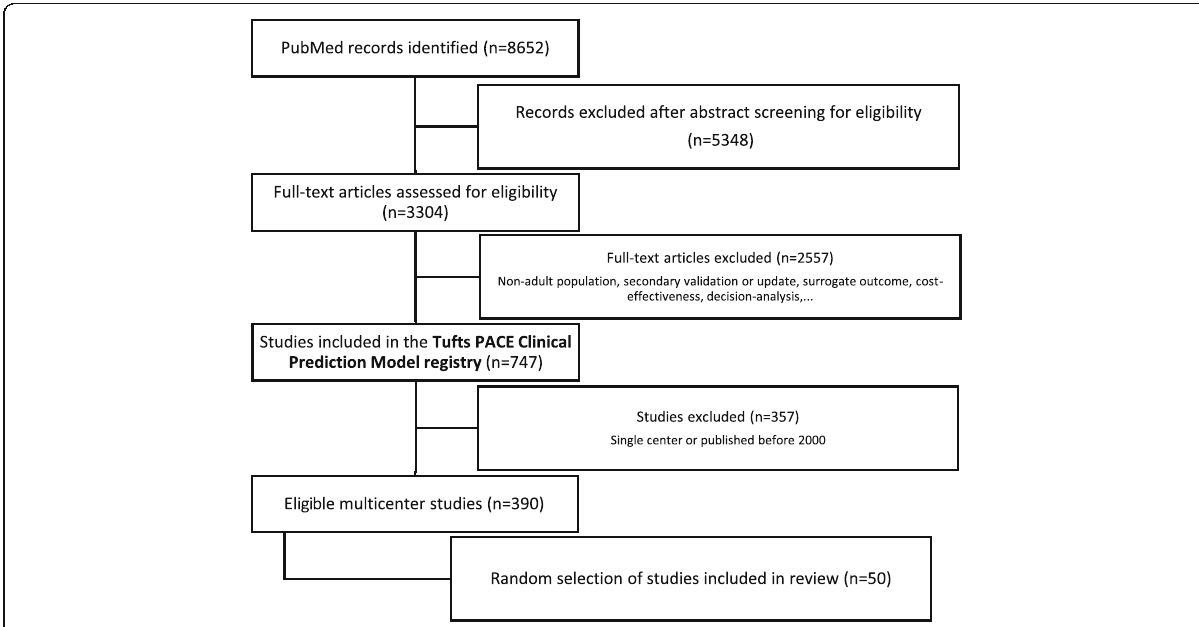
Fig. 2 The Tufts PACE Clinical Prediction Model Registry was searched for relevant multicenter articles published after